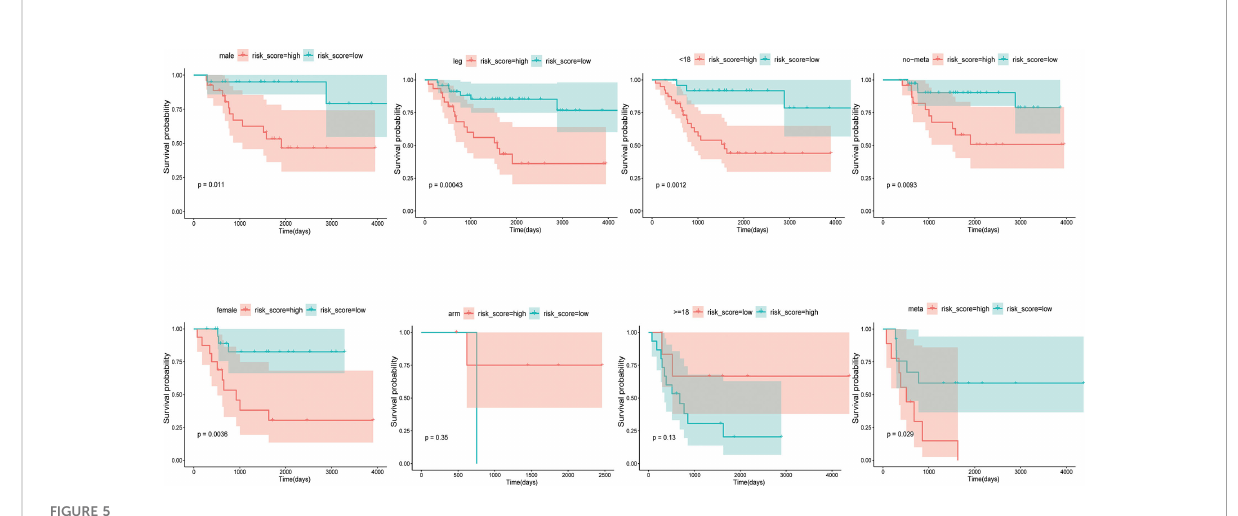
FIGURE 5 Kaplan-Meier curves of OS patients in different clinical